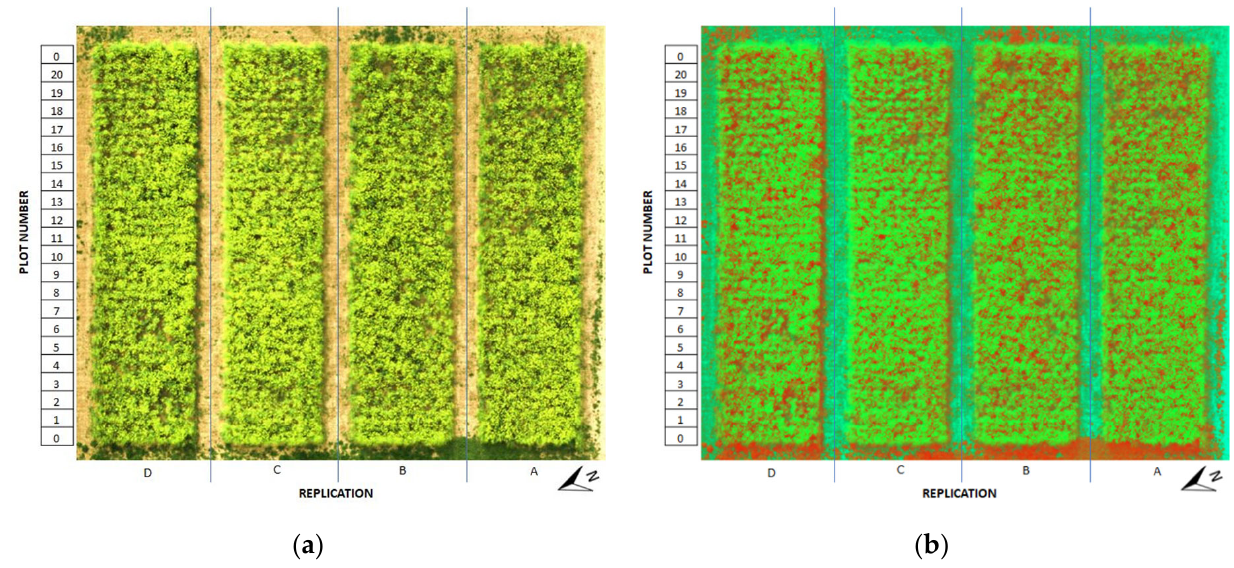
Figure 4. ( a ) Orthomosaic image of field trial with OSR acquired by UAV on 1 May 2020 in RGB ( a ) and red color negative ( b ) band combination. Both images show the crop status at flowering stage and the intensity of flowers within the monitored area.